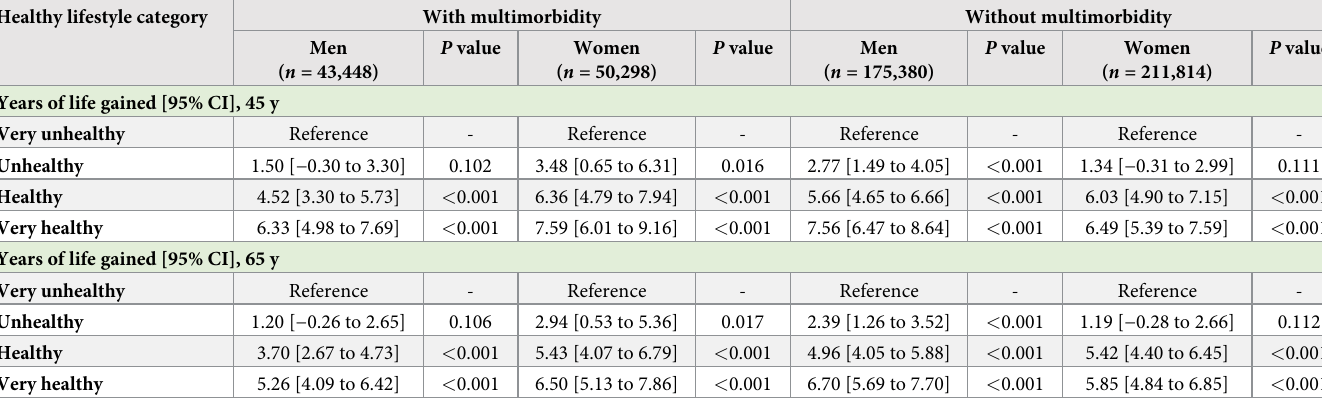
Models adjusted for ethnicity (white, non-white), working status (working, retired, other), deprivation (continuous), body mass index (continuous), sedentary time